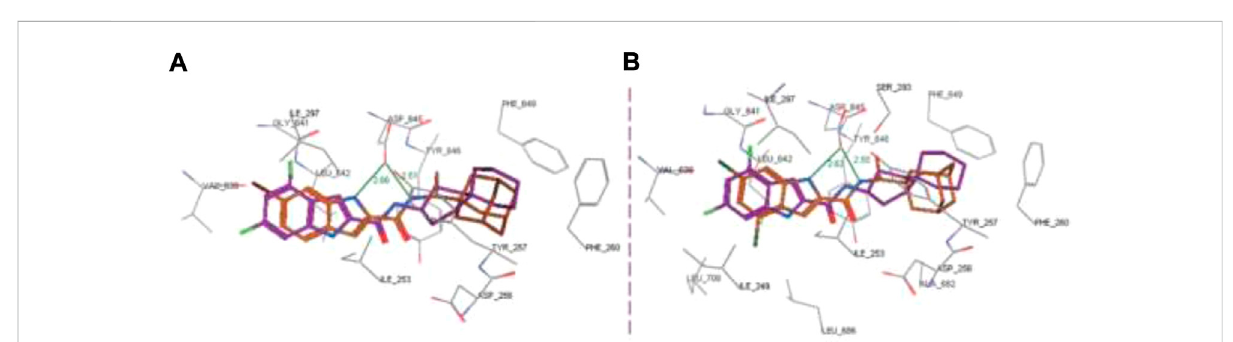
FIGURE 14 Superpositionoftop-rankeddockingpatternof 140(A) and 140(B) .ReproducedfromAlsayedetal.,2021,withpermissionfromRoyalSocietyof Chemistry, Copyright